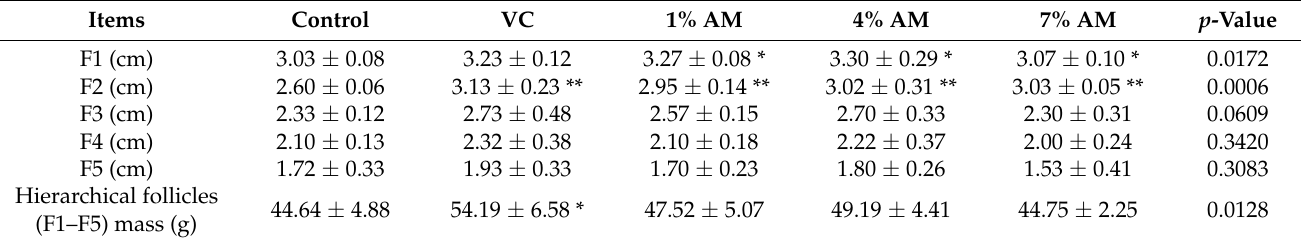
Table 3. Diameters and mass of hierarchical of laying hens.